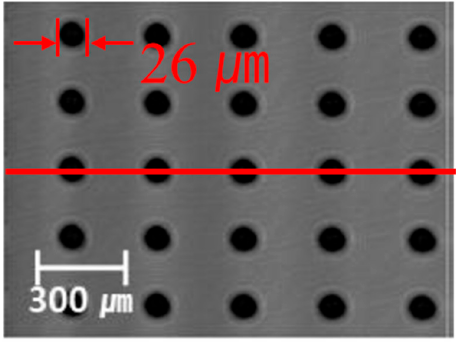
Figure 11. The –63 μ m defocusing B-Scan image of TSV. Figure 10. C-Scan image by the depth of TSV internal defect using acoustic microscope system im- aging technique.